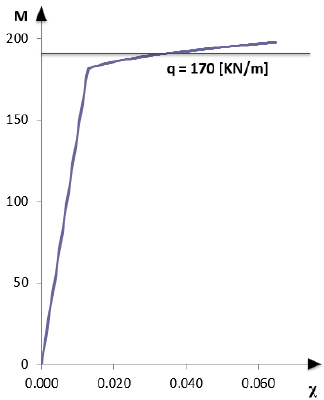
Figure 17. Bending moment-curvature diagram (q = 170 KN/m).